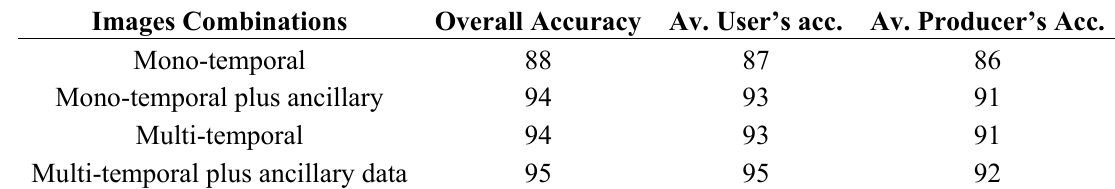
Table 11. Classification accuracy in 2011 (%) according to images combinations. Images Combinations